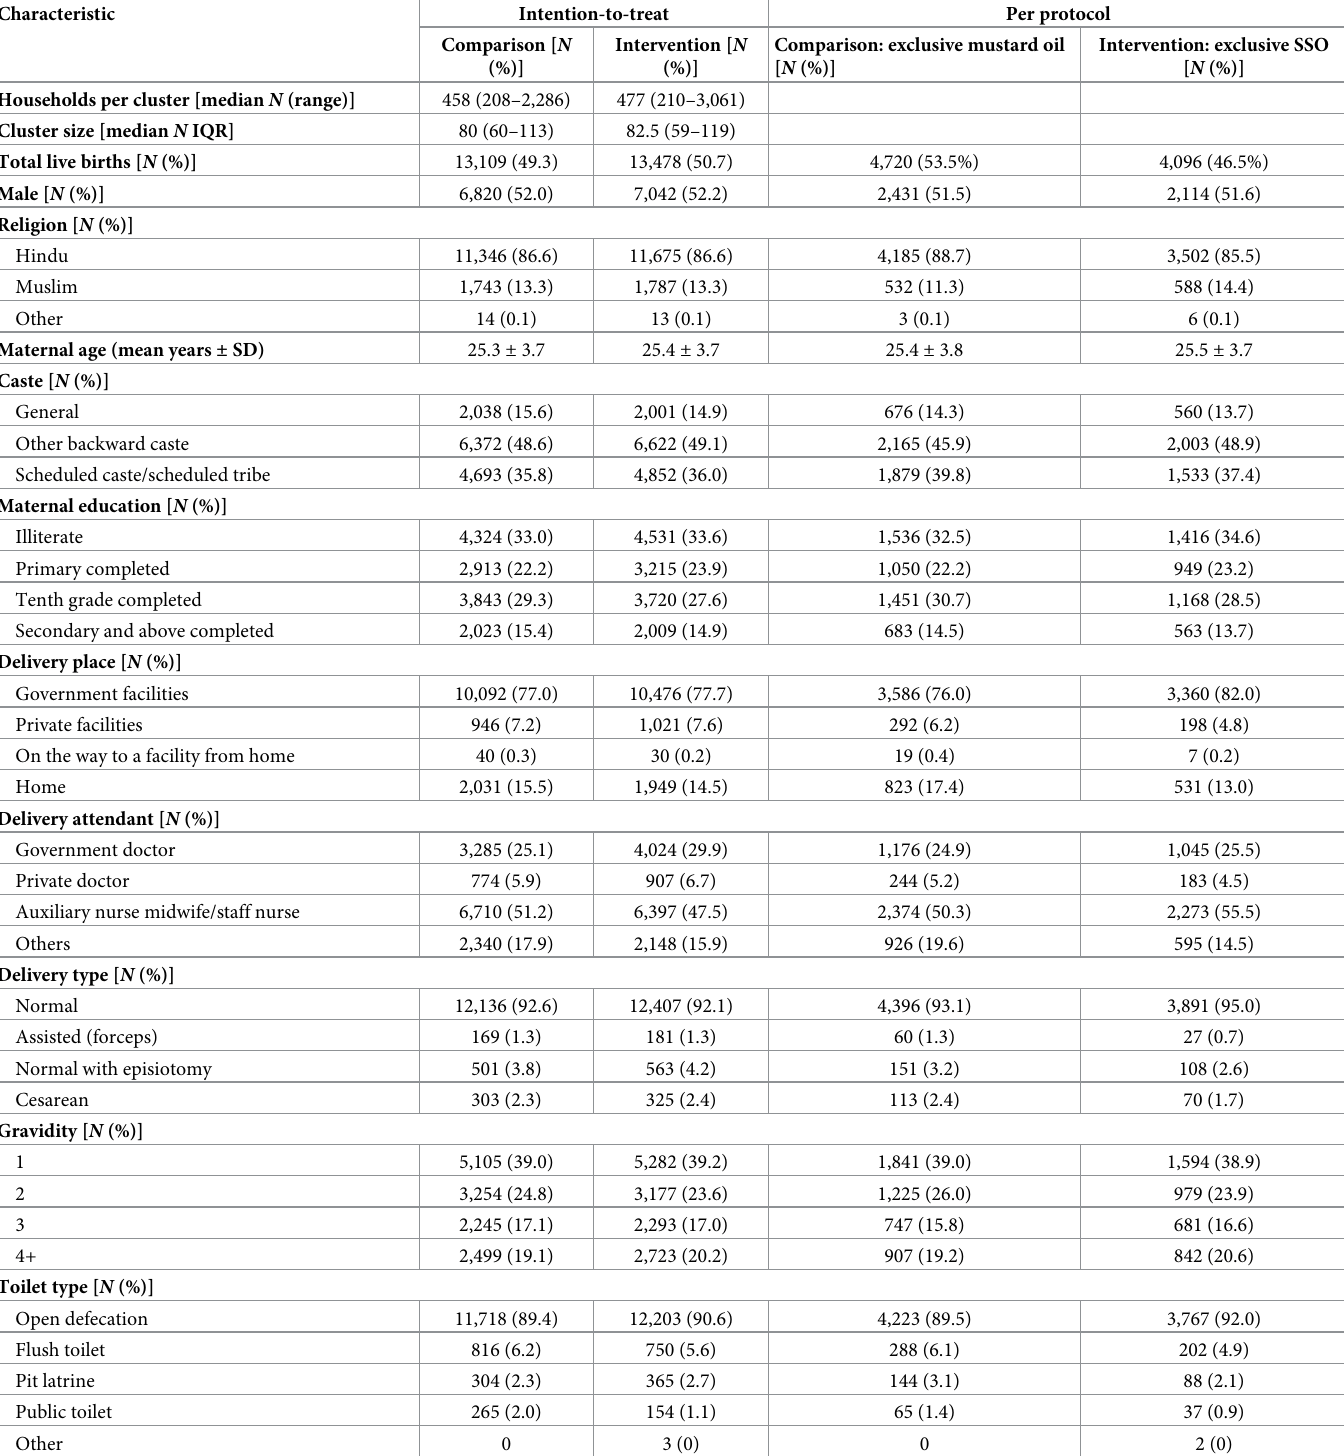
Table 1. Baseline characteristics of the study population randomized to intervention and comparison groups for intention-to-treat analysis and included in per- protocol analysis.